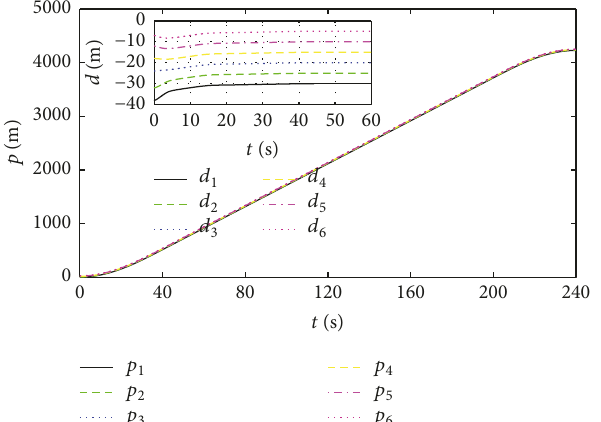
Figure 5: Velocities of vehicles with actuator saturation and absent velocity measurement.